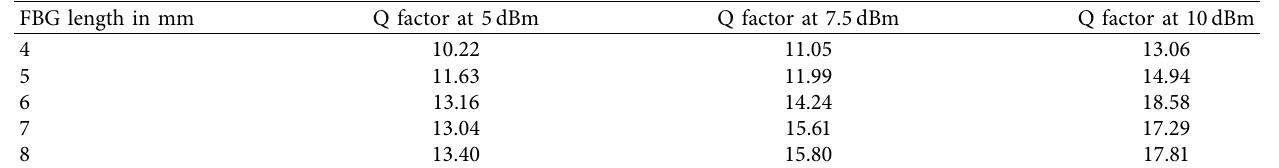
Table 4: Q-factor results for 3 FBG+DCF linear tanh apodization simulation